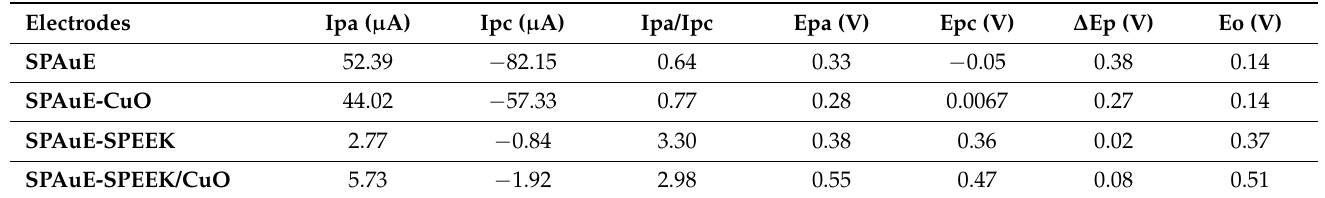
Figure 5. Comparative cyclic voltammogram of the fabricated electrodes (Au-Bare, Au-CuO NPs, Au-SPEEK, and Au-SPEEK/CuO NPs) in 5 mM K 3 [Fe(CN) 6 ] prepared in 0.1 M PBS (pH 7.4) at a scan rate of 25 mV/s. Table 1. Summary of cyclic voltammetry data of the different electrodes (Au-Bare, Au-CuO NPs, Au-SPEEK, and Au-SPEEK/CuO NPs) at a 25 mV/s scan